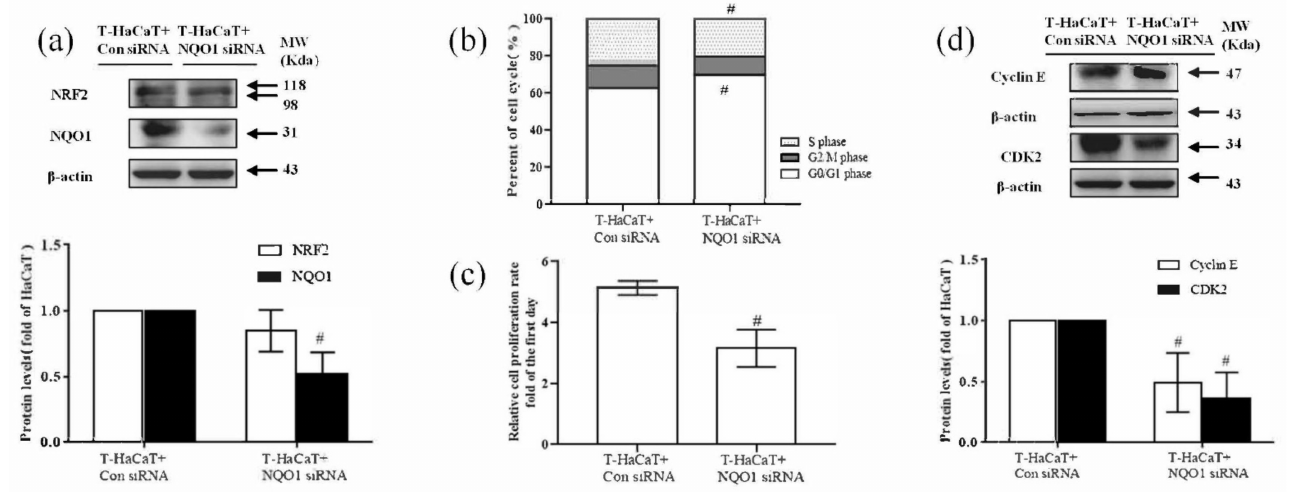
Figure 5. Effect of NQO1 on arsenite-induced malignant transformation of HaCaT cells. ( a ) Protein bands and relative protein levels of NRF2 and NQO1 in HaCaT cells and T-HaCaT cells with or without NQO1. ( b ) Changes in the cell cycle. ( c ) Change in the cell proliferation rate. ( d ) Protein bands and relative protein levels of cell cycle related protein Cyclin E and CDK2. Error bars are the mean ± SD ( n = 3). # Compared with control siRNA cells, p <